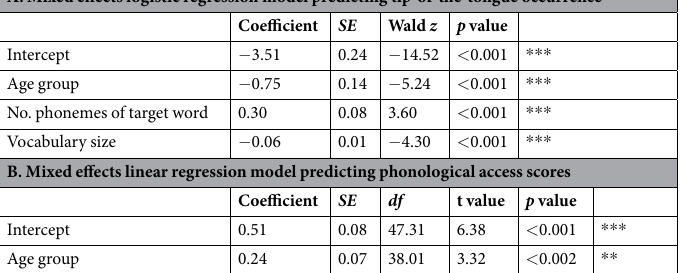
Table 1. Summary of the mixed effects regression models predicting tip-of-the-tongue occurrence and phonological access in young versus older adults. Table A note: N = 3300, AIC = 1699.5, log-likelihood = − 839.8. This model includes a random intercept for items and participants, a random slope for Vocabulary Size for items and a random slope for the Number of Phonemes of the Target Word for participants. Multicollinearity was low (all VIF < 1.4). Table B note: N = 272, AIC = 568.58. This model includes a random intercept for items